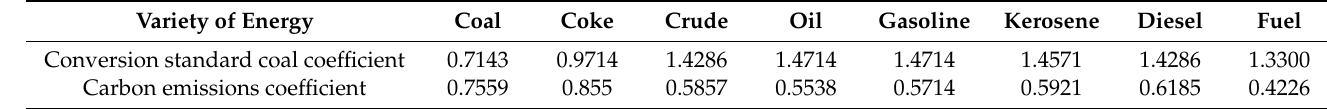
Table 1. The calculation coefficient for various energy